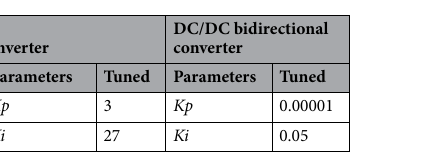
Figure 8. Schematic of proposed d-q control technique.